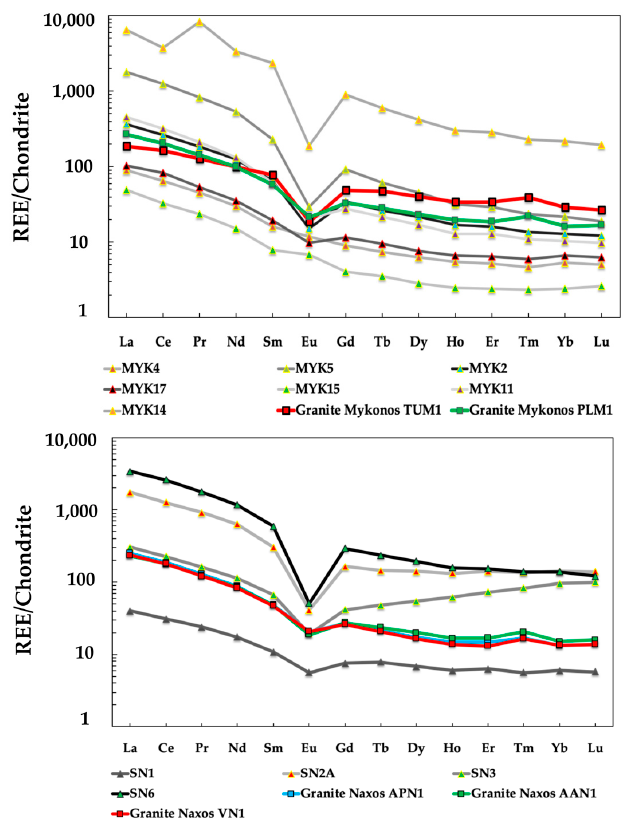
Figure 9. Chondrite REE patterns of Naxos and Mykonos coastal sands compared to the source rocks (Modified from Papadopoulos et al. [64]). In other areas such as Paros, Tinos, Serifos and Ikaria, the REE concentrations carry no obvious commercial appeal. More specifically, coastal sand samples from Serifos are dominated by REE-poor minerals such as epidote, garnet, and pyroxene, which are indicative of a metamorphic and/or metasomatic (skarn) origin. This metamorphic-derived fraction of heavy minerals dilutes the modal abundance of allanite and thus the potential of the studied sands in REE. Samples from Tinos are likewise enriched in a similar suite of minerals (epidote, amphiboles and pyroxenes) that point to an origin largely from the meta-ophiolitic rocks of the area. These minerals are evidently also not associated with high REE concentrations.